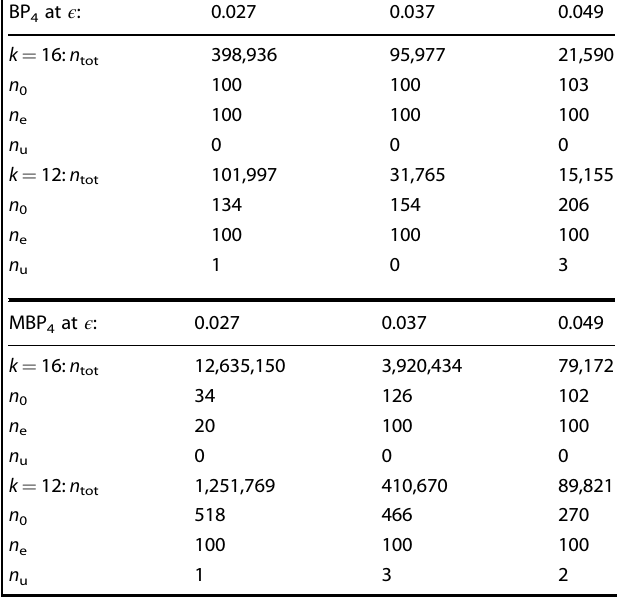
Table 1. Numbers of various events in the simulations of BP 4 and MBP 4 on the bicycle codes of row-weights 16 and 12.